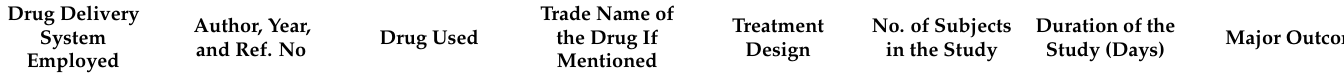
Table 1. Studies investigating role of various locally delivered fibre systems in the treatment of periodontal disease in the past 10 years. Drug Delivery